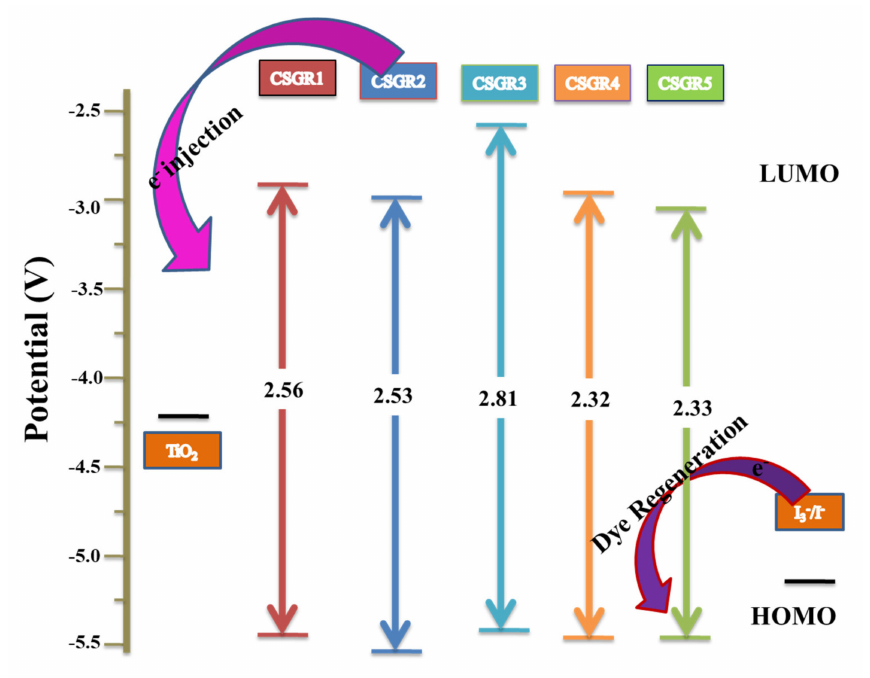
Figure 7. The schematic energy level diagram for CSGR1-5 based on UV-visible absorption and electrochemical